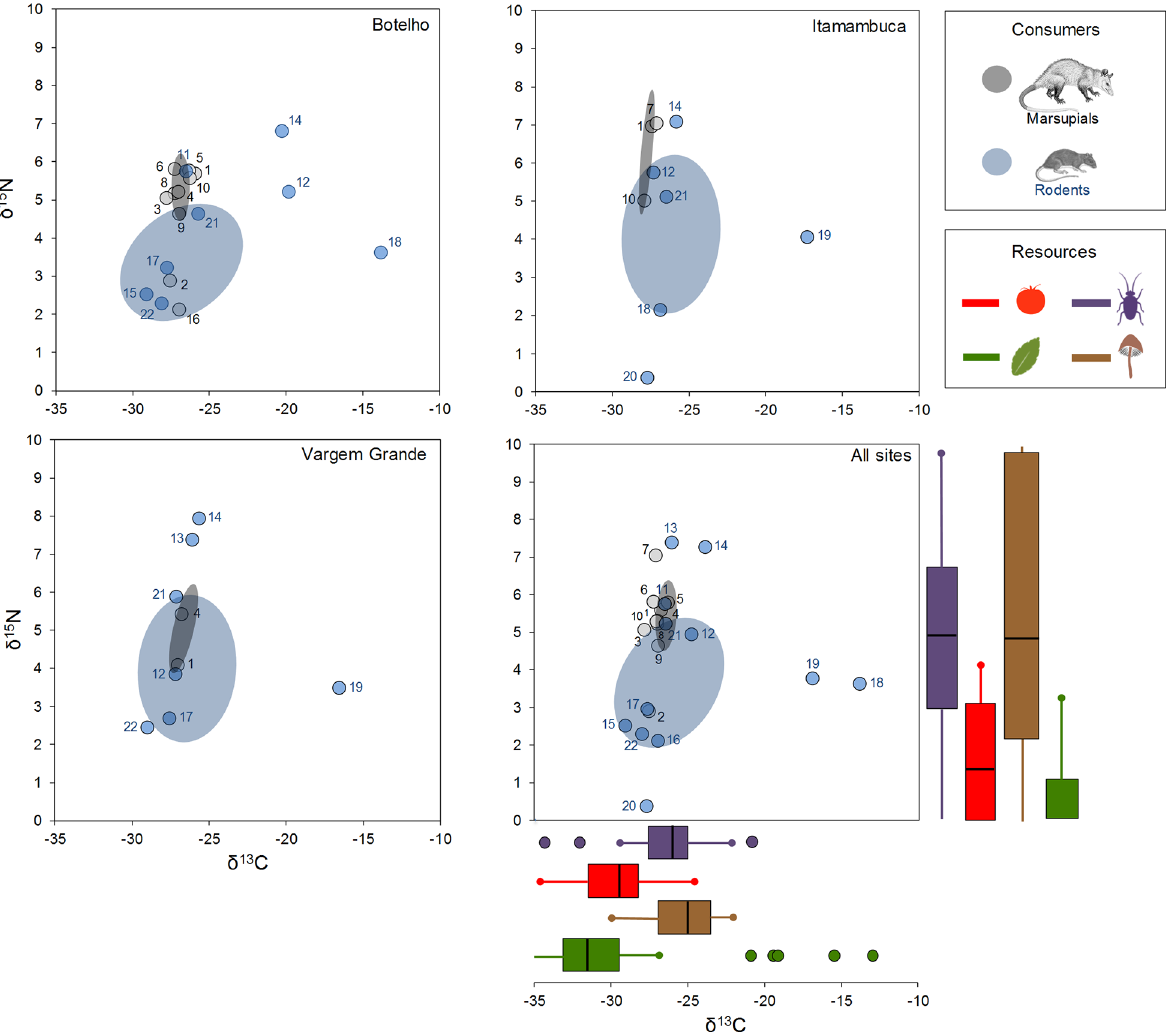
Fig 2. Isotope plot depicting means isotope values ( δ 15 N and δ 13 C) of rodent (gray dots) and marsupial (blue dots) species from Atlantic rainforests, with respective standard isotope ellipses, for each studied site and all sites polled together. Isotope values were corrected downward 2.7 ‰ (for δ 15 N) and 2.4 ‰ (for δ 13 C) to account for trophic enrichment. Isotope values of the potential food resources are represented in boxplots. Species code: 1 = Didelphis aurita ; 2 = Gracilinanus microtarsus ; 3 = Juliomys pictipes ; 4 = Marmosops incanus ; 5 = Metachirus nudicaudatus ; 6 = Monodelphis Americana ; 7 = Monodelphis iheringi ; 8 = Monodelphis scalops ; 9 = Monodelphis sp.; 10 = Philander frenatus ; 11 = Akodon cursor ; 12 = Akodon montensis ; 13 = Blarinomys breviceps ; 14 = Brucepattersonius soricinus ; 15 = Delomys dorsalis ; 16 = Delomys sublineatus ; 17 = Euryoryzomys russatus ; 18 = Necromys lasiurus ; 19 = Oligoryzomys nigripes ; 20 = Sooretamys angouya ; 21 = Thaptomys nigrita ; 22 = Trinomys iheringi .